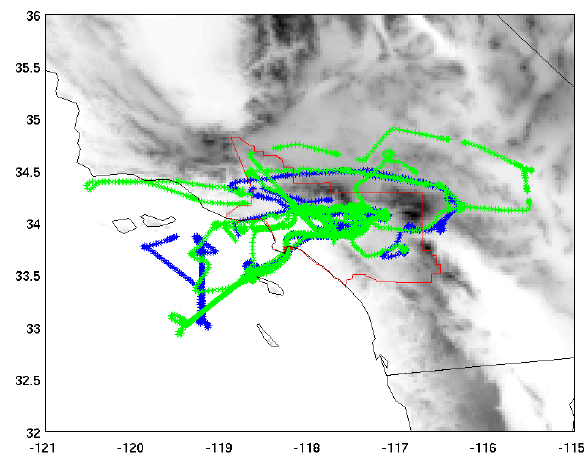
Fig. 1. Map of the domain showing the flight tracks from the 3 Figure 1. Map of the domain showing the flight tracks from the 3 weekday flights (blue) and 2 weekday flights (blue) and 3 weekend flights (green) of the NOAA 3 weekend flights (green) of the NOAA P-3 aircraft during CalNex used in this study. The red 3 P-3 aircraft during CalNex used in this study. The red region refers region refers to the South Coast Air Basin (SoCAB) area. 4 to the South Coast Air Basin (SoCAB)